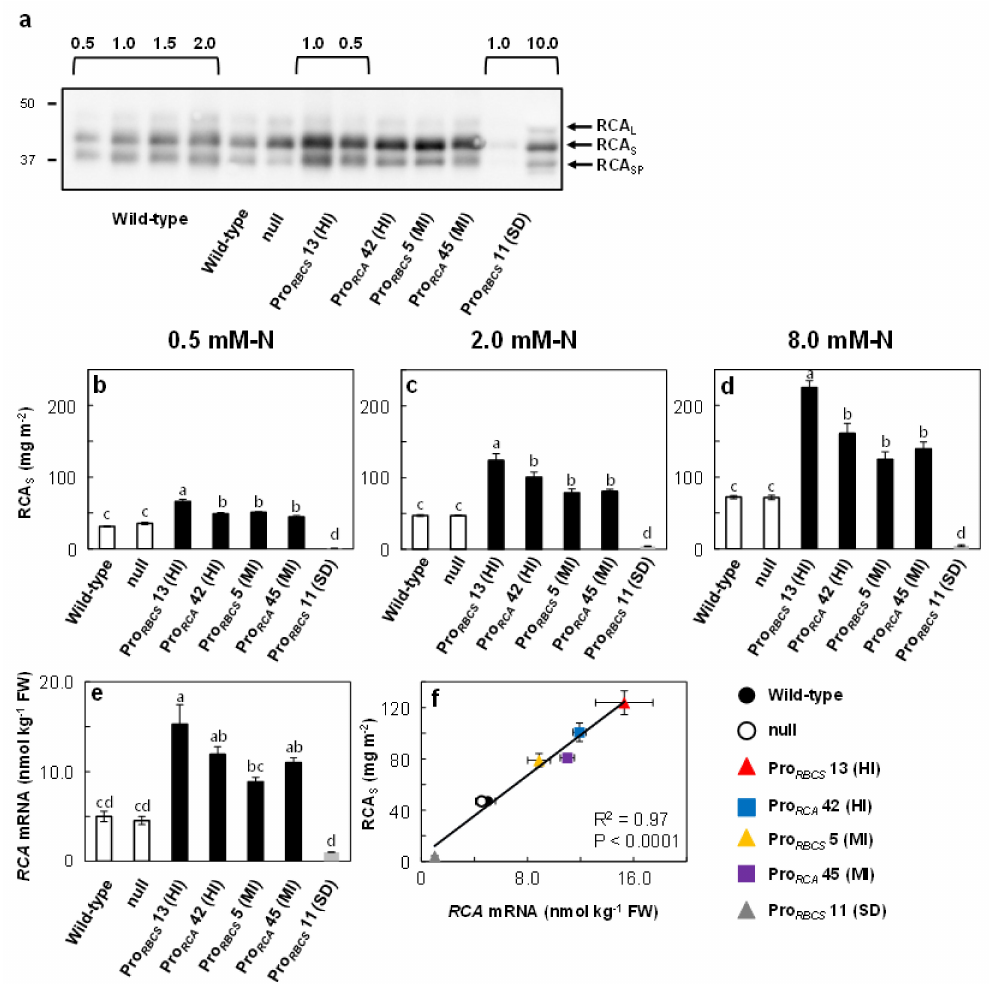
(RCA SP , bottom band) described in Vargas-Su á rez et al. [41] (Figure 1a). The selected RCA increase or decrease lines, wild-type plants, and null segregants were grown hydroponically with three di ff erent N concentrations (0.5, 2.0, and 8.0 mM-N). The content of the small form of RCA (RCA S ) was increased by 112%–212% and 57%–123% in Pro RBCS 13 (HI) and Pro RCA 42 (HI), and by 63%–73% and 43%–93% in Pro RBCS 5 (MI) and Pro RCA 45 (MI), respectively, relative to wild-type plants. In Pro RBCS 11 (SD), the RCA content was less than one-tenth of that detected in wild-type plants (Figure 1b-d). We also determined the mRNA levels of RCA by qRT-PCR in plants grown at 2.0 mM-N. The mRNA levels of RCA were increased by 205%, 138%, 77%, and 120% in Pro RBCS 13 (HI), Pro RCA 42 (HI), Pro RBCS 5 (MI), and Pro RCA 45 (MI), respectively, and decreased by 80% in Pro RBCS 11 (SD) (Figure 1e). RCA mRNA level was strongly correlated with RCA S protein amount (Figure 1f).